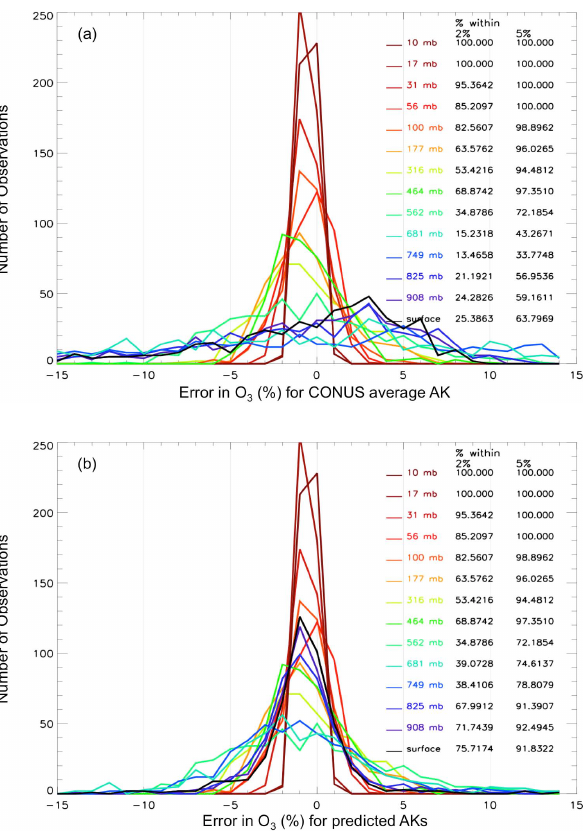
Fig. 16. (a) Performance of CONUS average AK compared to true AKs for TES-OMI test cases. (b) Performance of predicted AKs compared to true AKs for TES-OMI test cases. For pressures be- low 600hPa, the CONUS average AK is applied. Histograms of error in O 3 are plotted for each pressure (indicated by colors on the right). Listed on the far right are the percentages of test cases that fall within 2 and 5% O 3 error for each